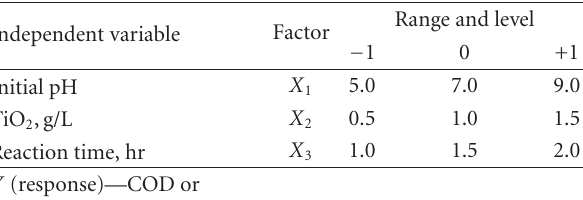
Table 2: Experimental range and levels of the process independent variables in this study.